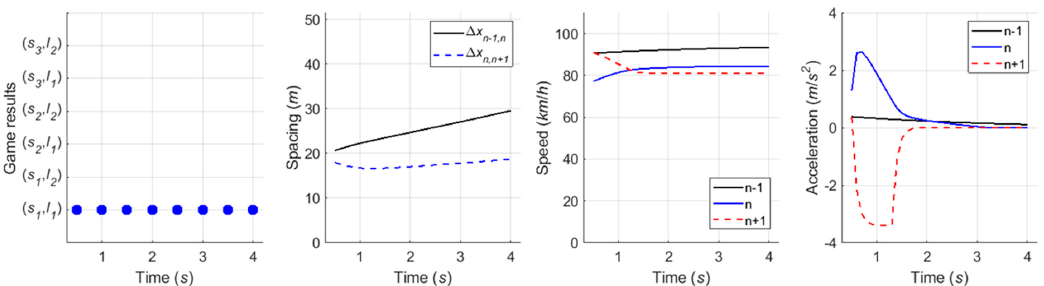
Figure 17. Decision-making game results in case 1.